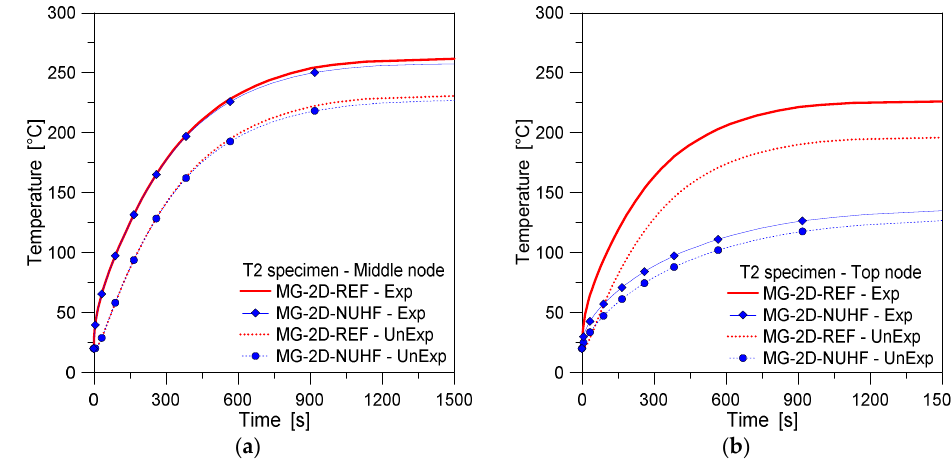
Figure 14. FE results (ABAQUS, 2D) for the MG specimen T2, by changing the heat flux distribution on the front surface of the glass panel. Temperature history comparisons at the ( a ) middle and ( b ) top edge